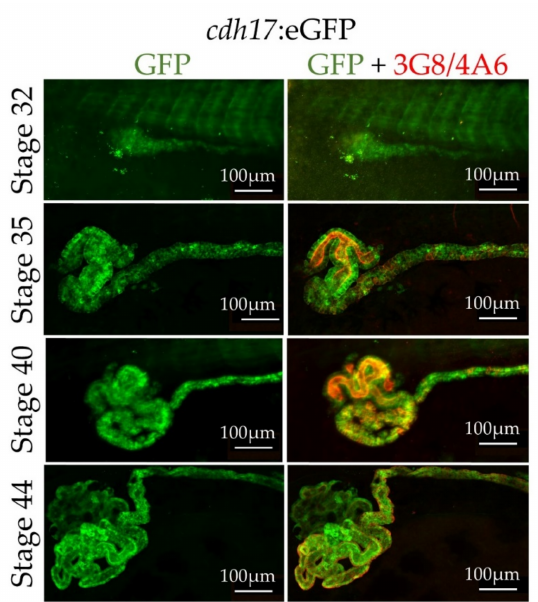
Figure 4. cdh17 :eGFP labels the kidney throughout pronephric development. Stage 32 through stage 44, cdh17 :eGFP transgenic X. laevis embryos were immunostained with antibodies for GFP and the kidney markers 3G8 and 4A6. GFP expression is present throughout pronephric kidney development. ( Left ) GFP expression, ( right ) GFP (Green) and 3G8/4A6 (red) kidney marker